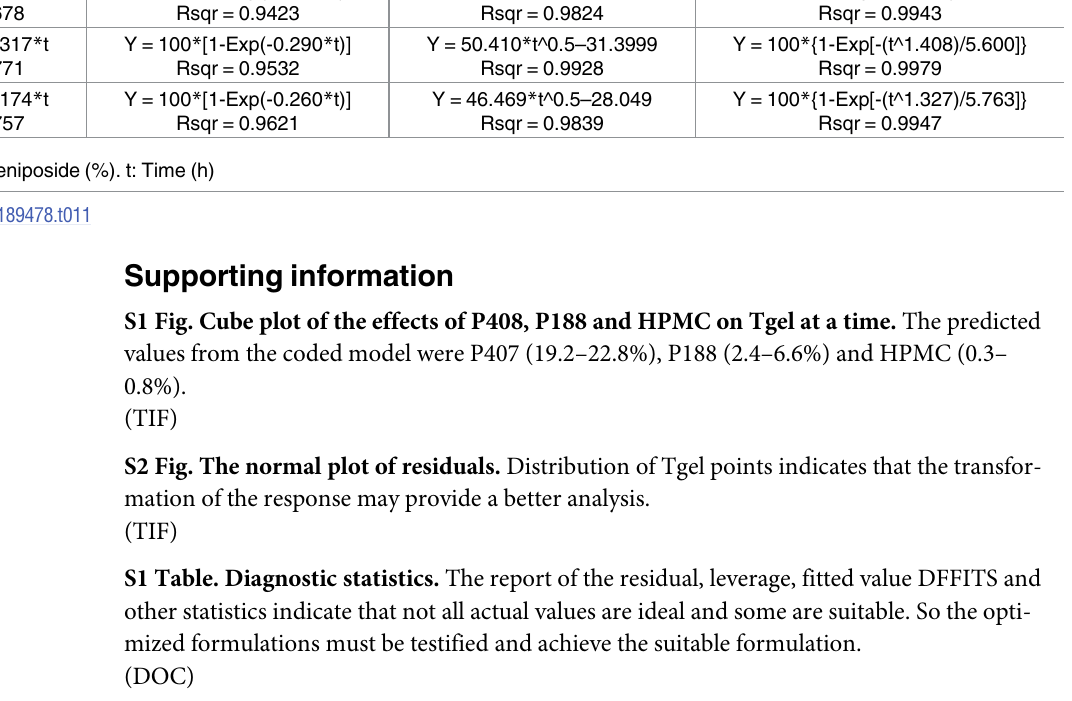
S1 Table. Diagnostic statistics. The report of the residual, leverage, fitted value DFFITS and other statistics indicate that not all actual values are ideal and some are suitable. So the opti- mized formulations must be testified and achieve the suitable formulation.